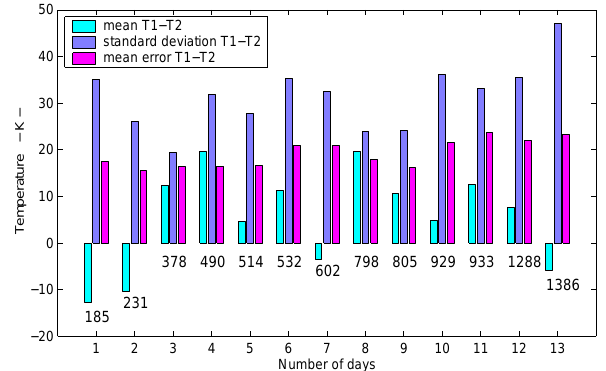
Fig. 5. Mean temperature differences between the two FOVs for 13 days, averaged over the altitude range of 180 to 260km. The standard deviations of the differences and the mean errors are also